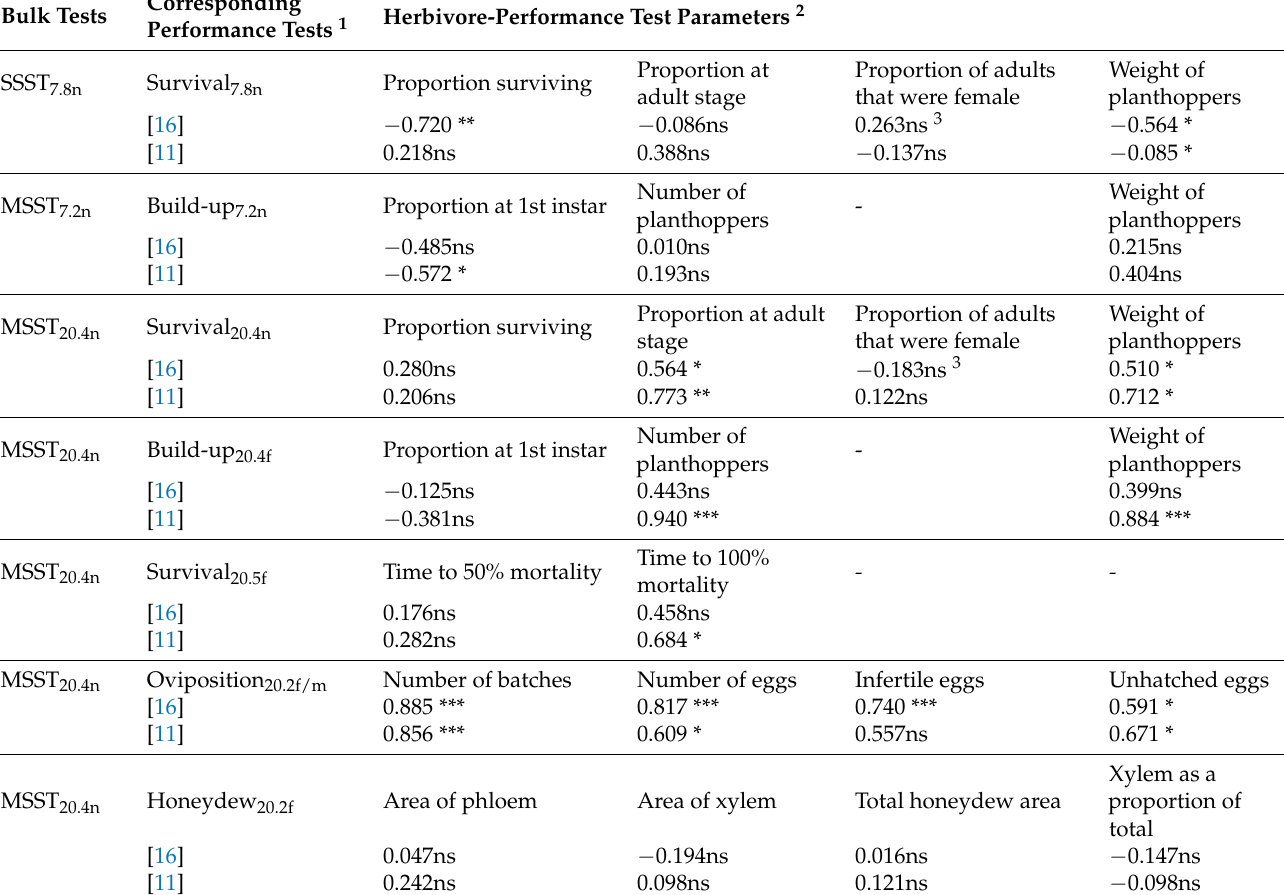
1. Numbers in square brackets are degrees of freedom for Spearman’s correlations. Correlations were tested for all 16 varieties and for 11 varieties with damage ratings of ≤ 7 during tests. 2. Herbivore-performance test parameters are indicated as sub-headings. Means for each parameter and variety are presented in Tables S1–S10. Numbers are Spearman’s correlation coefficients; *** = p < 0.001, ** = p < 0.01, * = p < 0.05, ns = p > 0.05. 3. N = 15 because no adults emerged on